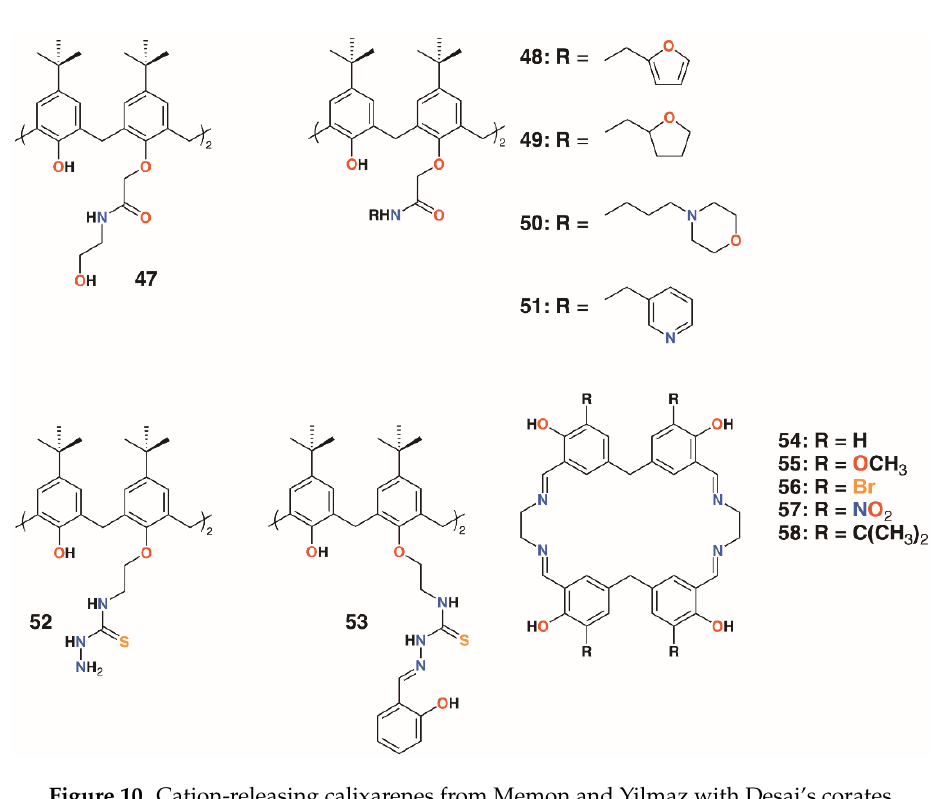
Figure 10. Cation-releasing calixarenes from Memon and Yilmaz with Desai’s corates.